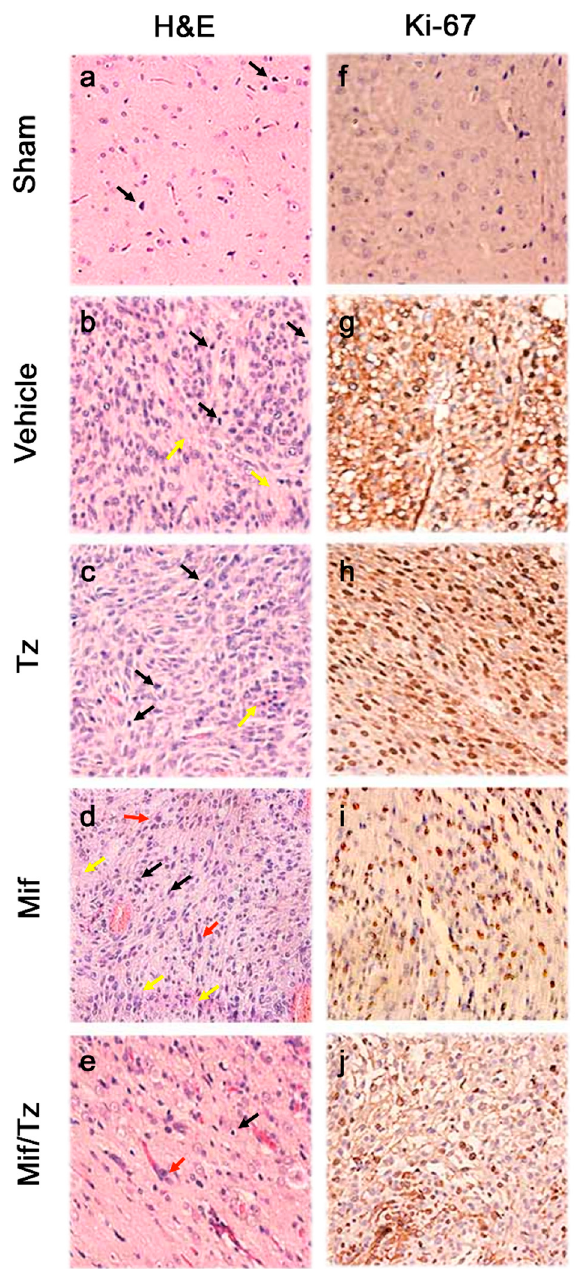
Figure 3. Haematoxylin and eosin (H&E) staining and immunohistochemical analysis of glioma tissue. Sections of tumor tissue were stained with haematoxylin and eosin ( a – e ): Mitosis (black arrows), nuclear pleomorphism (red arrows) and necrosis (yellow arrows). Immunostaining of Ki-67 ( f – j ), showing few cell nuclei positive to this protein in the tumors of the Mif/Tz group compared to those of the individual treatments (Tz or Mif). The images are representative of three animals per treatment. Magnification 40×.